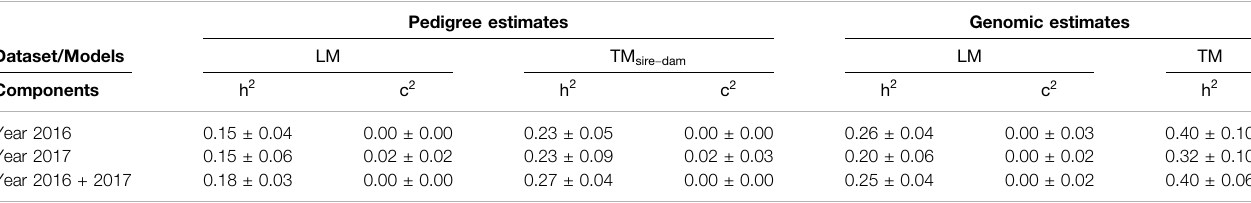
TABLE 2 | Genetic parameters with standard errors for survival at the end of the VNN challenge